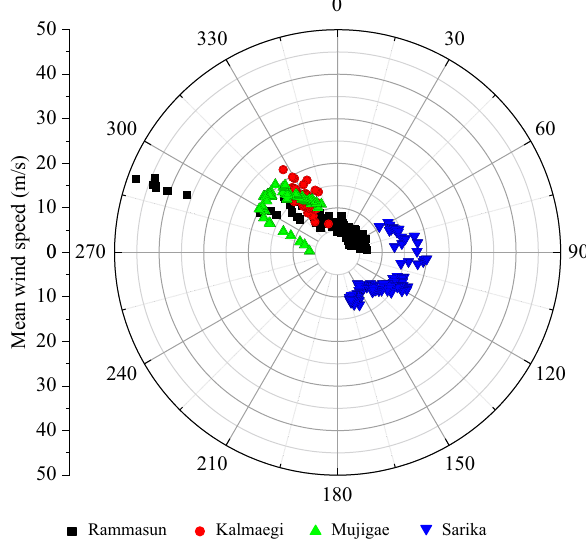
floorFigure 3. Wind field characteristics of Typhoons Sarika, Kalmaegi, Mujigae, and